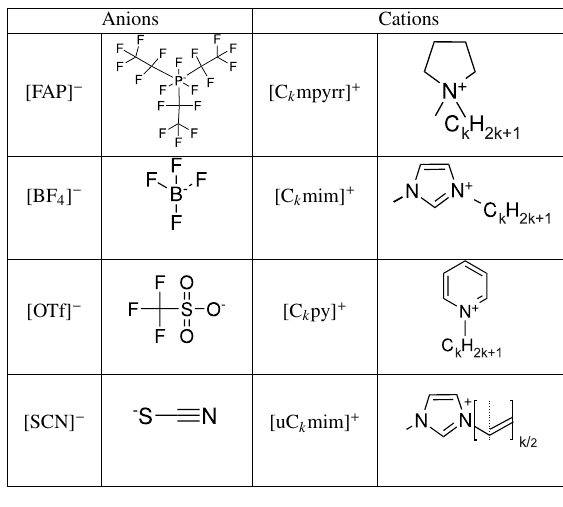
Table 3. α i / V i ratio of considered cations.